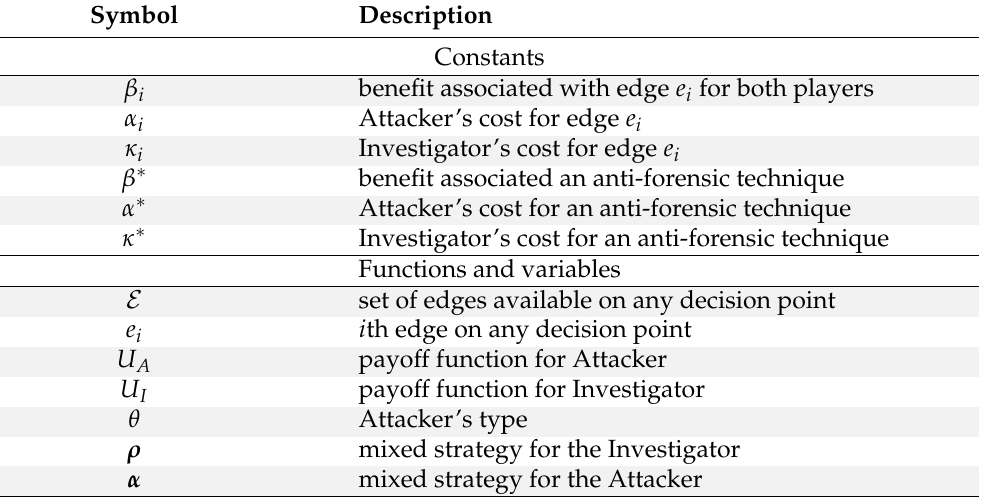
Table 1. List of